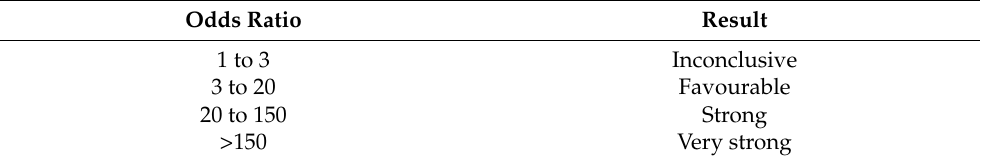
Table 4. Evidence of effects.